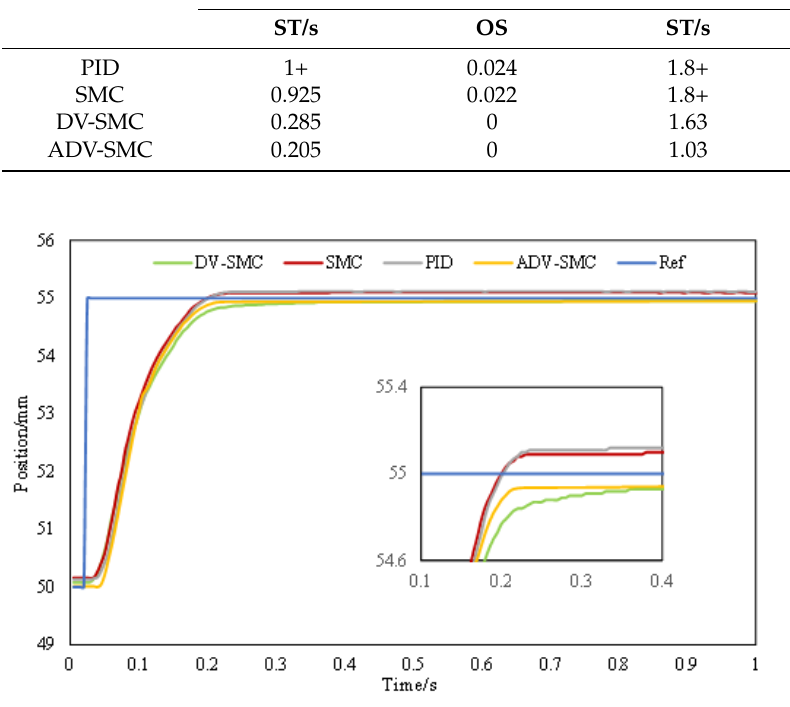
Figure 6. Experimental response to 50 mm step input. Figure 7 presents the results of tracking